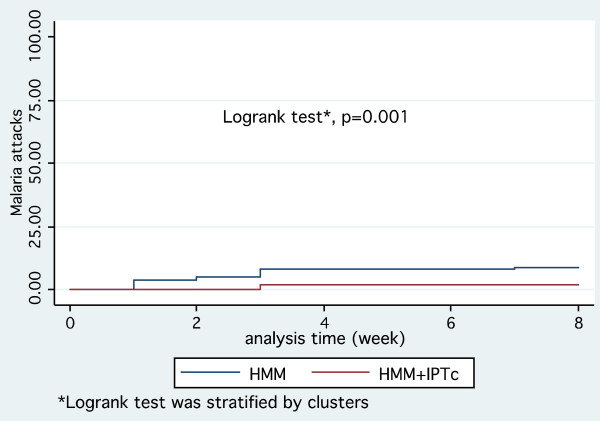
Kaplan-Meier plot comparing time to first episode of malaria attack defined as fever (> 37.5°C) and positive RDT, between the two groups.